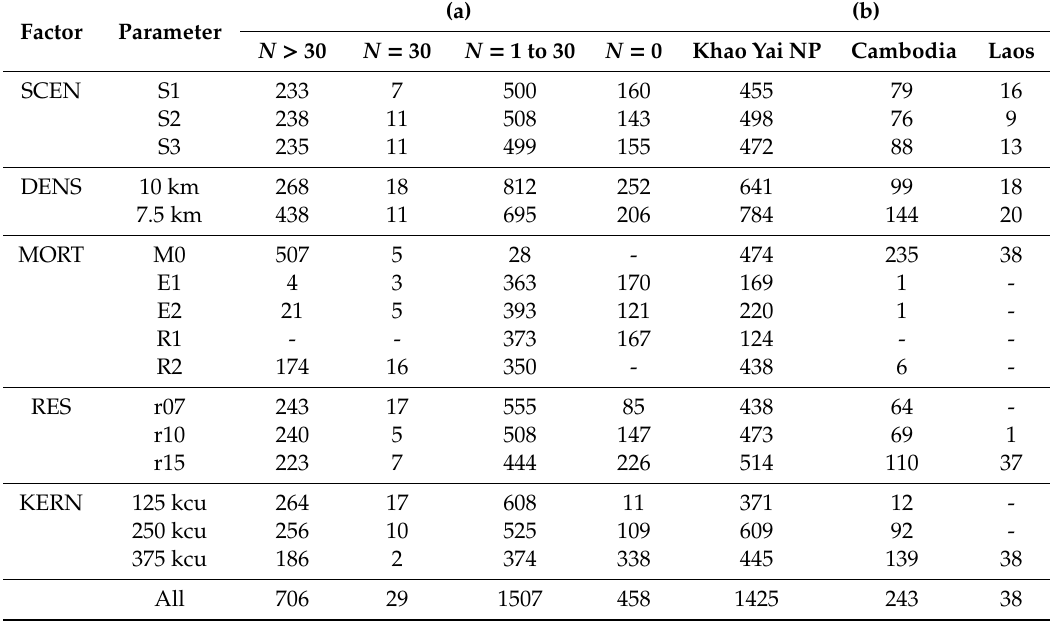
Table 1. Summary of simulation results within factor groups by parameter at timestep 9 out of 2700 simulations. Results are summarized by ( a ) simulated population ( N ) at timestep 9 and ( b ) number of simulations in which source points were generated in Khao Yai National Park (NP), Cambodia, or Laos at timestep 9 (e.g., successful colonization). This reflects a summary of all simulation results specific to each factor group—resistance surface (highway mitigation scenario (SCEN) and resistance transformation, (RES)), dispersal ability (KERN), population density (DENS), and mortality function (MORT)—amalgamating all other factors and parameters. A detailed breakdown of simulation results can be found in Supplementary Materials 2; Tables S1 and